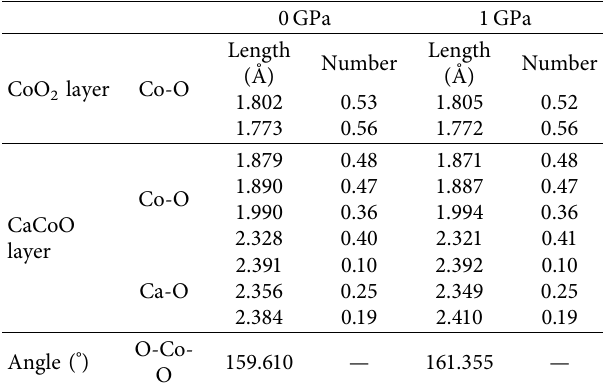
Table 2: Binding lengths and binding numbers within sandwiched Ca 2 Co 2 O 5 crystalline